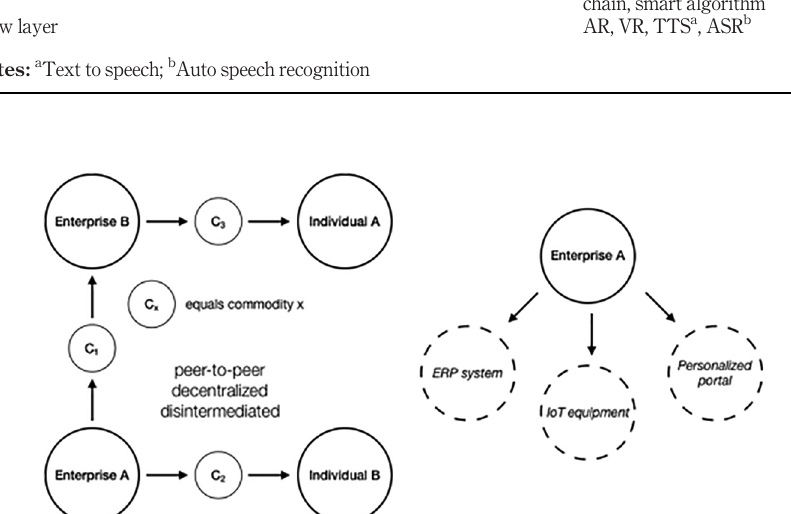
Table I. Basic architecture of